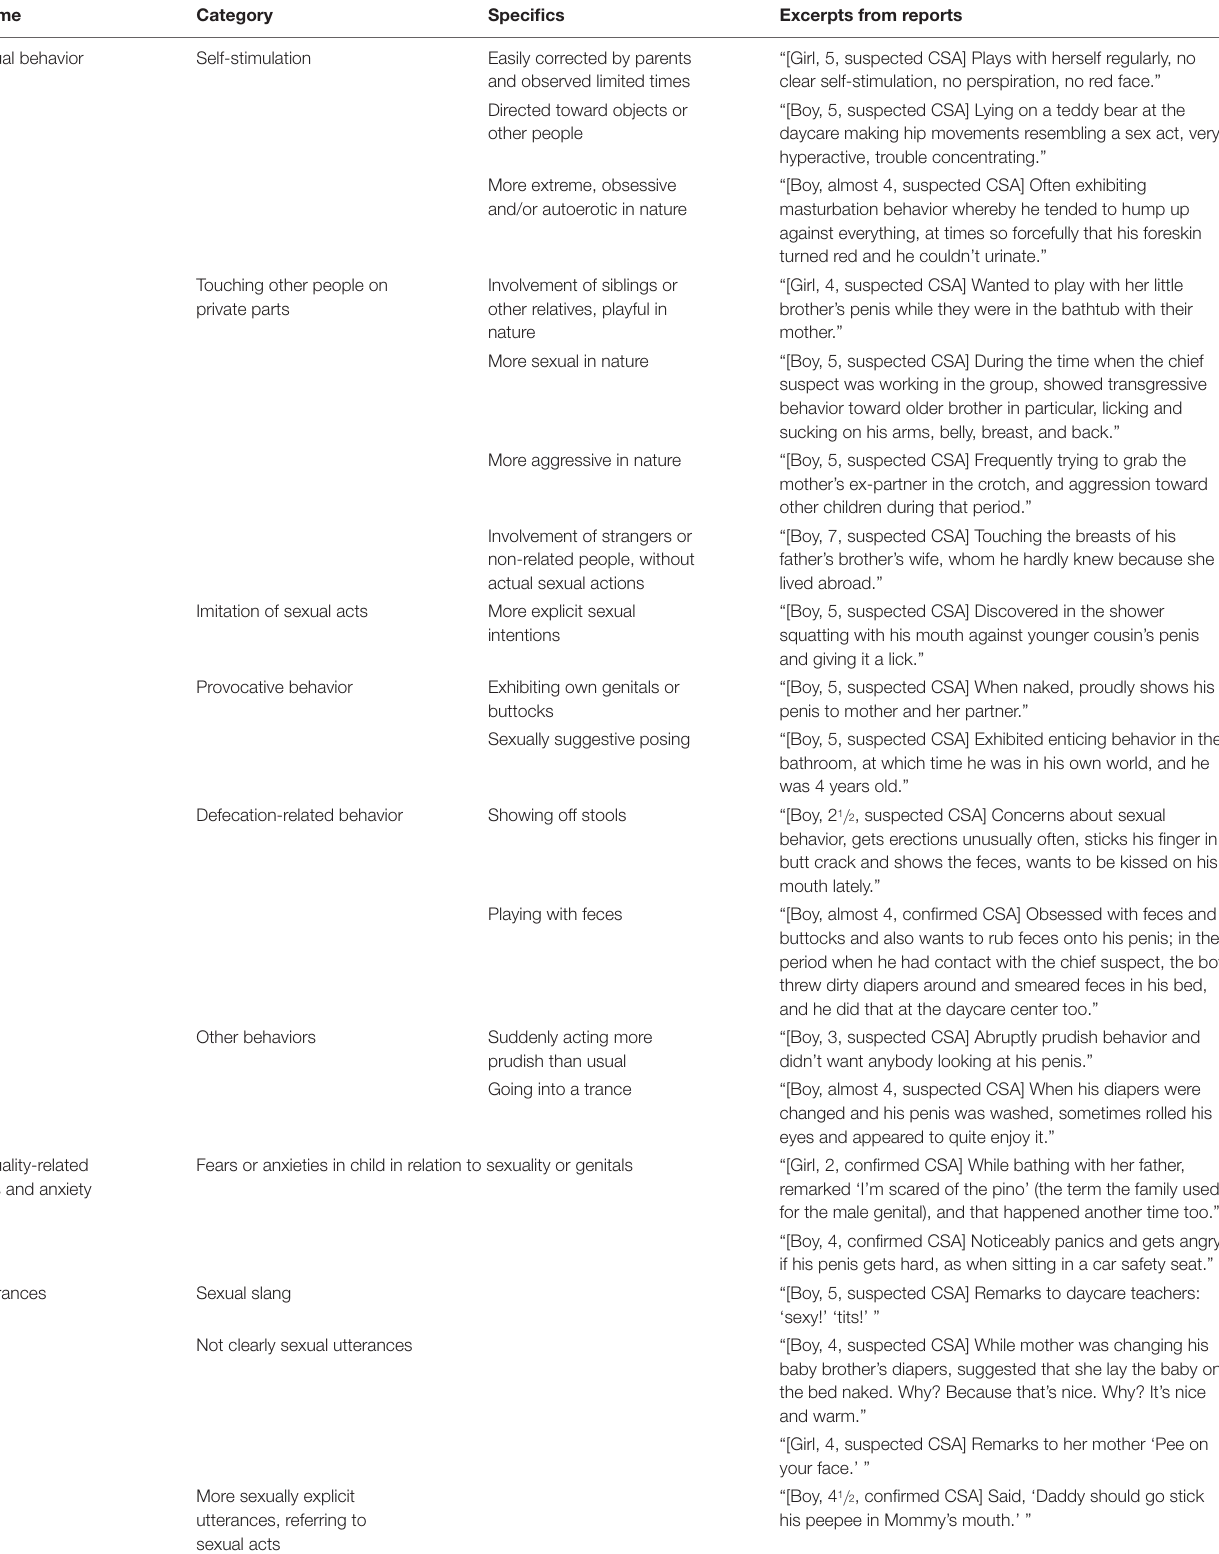
TABLE 3 | Themes derived from parent